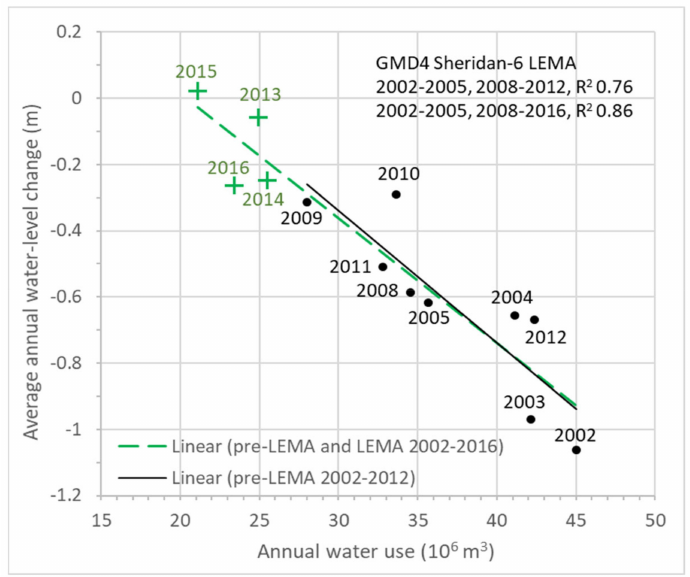
Figure 3. Average annual water level change versus annual groundwater use for the SD-6 LEMA in GMD4. Source: data for Figure 3 in Butler et al.